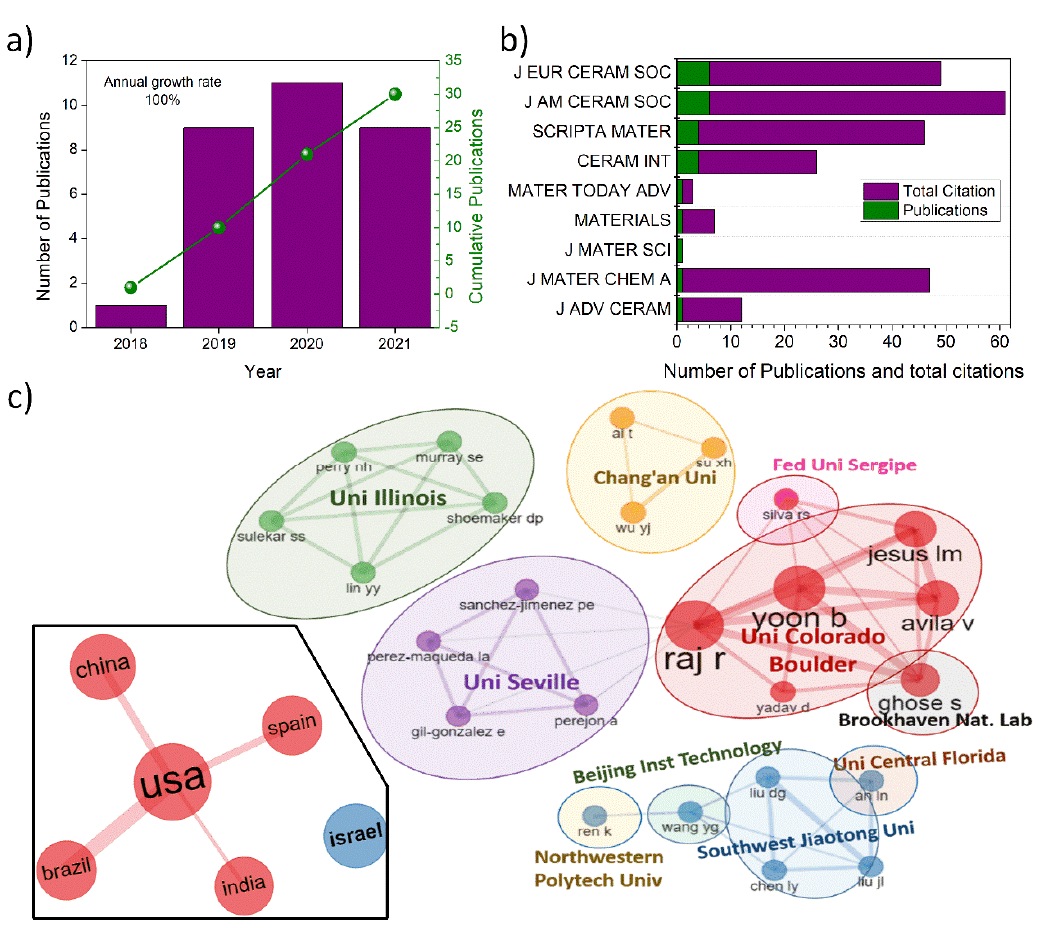
Figure 5. ( a ) Annual and cumulative publications, ( b ) number of documents and total citations per source, and ( c ) country, author, and institution collaboration networks in RFS. The author and institution collaboration networks are limited to those with more than two publications and at least one co-authored document.